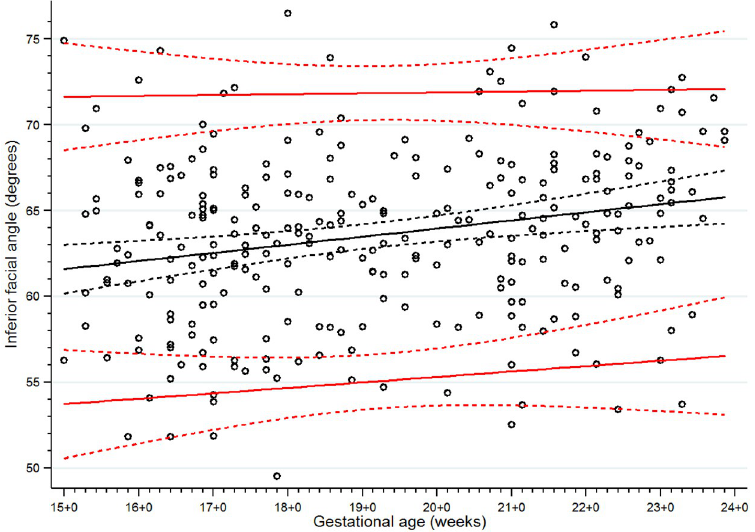
Fig 6. Scatter plot of inferior facial angle (IFA) along gestational age. Solid lines represent the IFA values in the 5th, 50th and 95th percentiles, Dashed lines represent the 95% confidence interval for each given percentile.